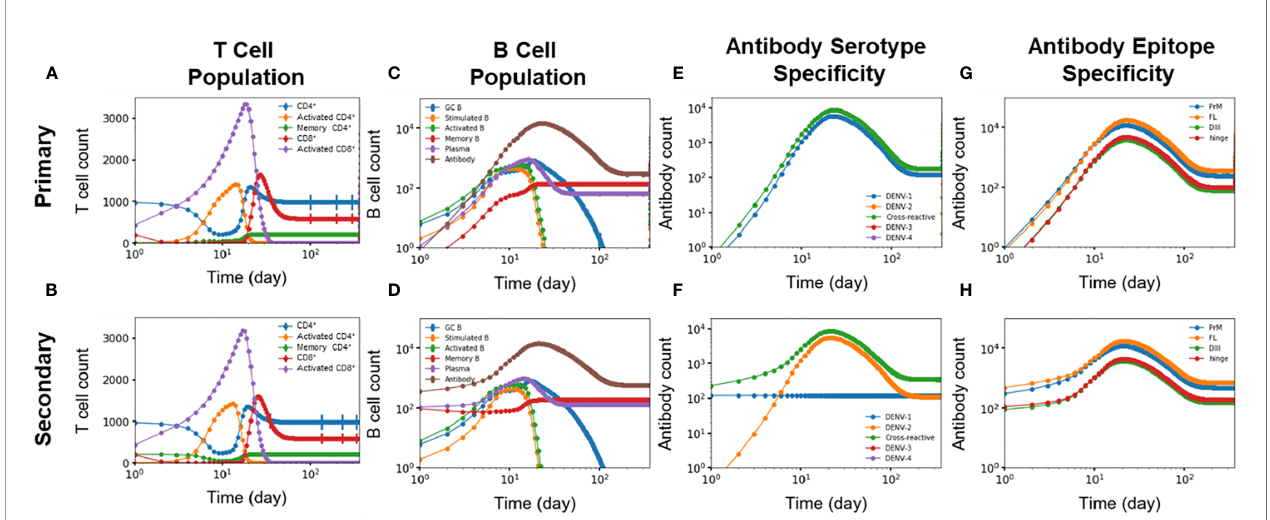
FIGURE 5 | (A, B) T cell population (n units x 10 3 /ml), (C, D) B cell population, antibody speci fi city at (E, F) serotype and (G, H) epitope levels from primary and secondary heterotypic infections as a function of time from 10,000 independent